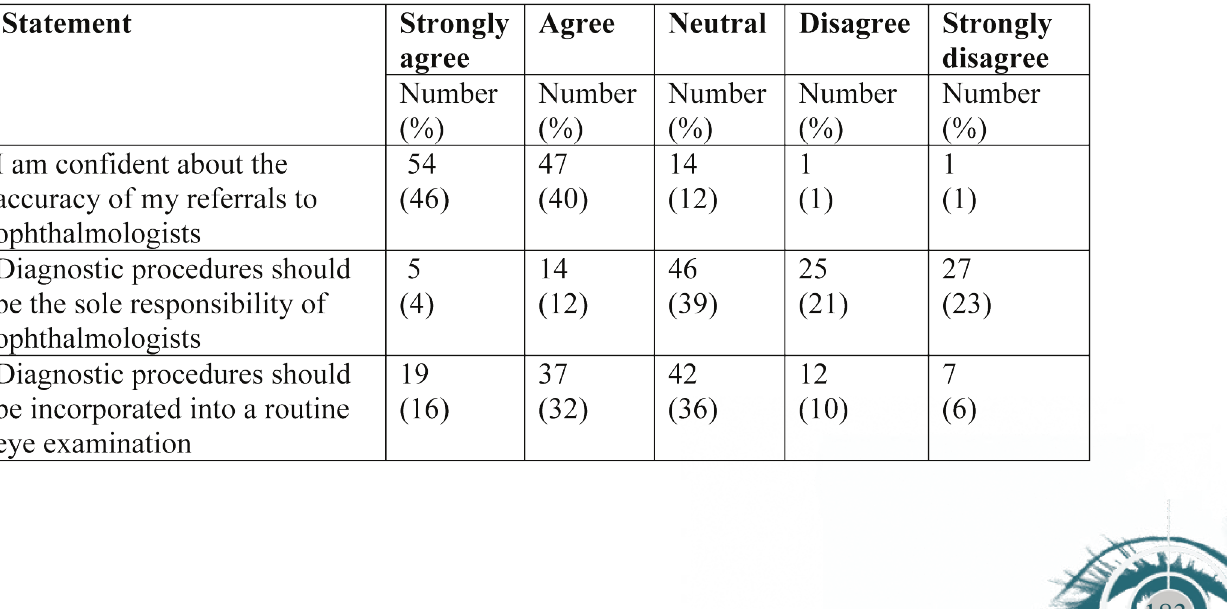
The South African Optometrist